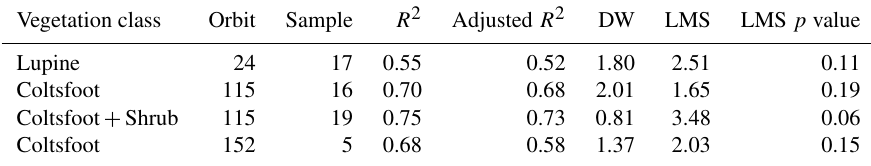
Table C1. Statistical test results for CPD and snow depth correlation analysis. Each model represents a divided sample in function of vegetation class and TSX orbit. Results with an R 2 greater than 0.5 are shown. The Durbin–Watson test (DW) and the Breusch–Pagan test (LMS, Lagrange multiplier statistic) were selected to assess the autocorrelation for the first and the homoscedasticity for the latter. Vegetation class Orbit Sample R 2 Adjusted R 2 DW LMS LMS p value Lupine 24 17 0.55 0.52 1.80 2.51 0.11 Coltsfoot 115 16 0.70 0.68 Coltsfoot + Shrub 115 Coltsfoot